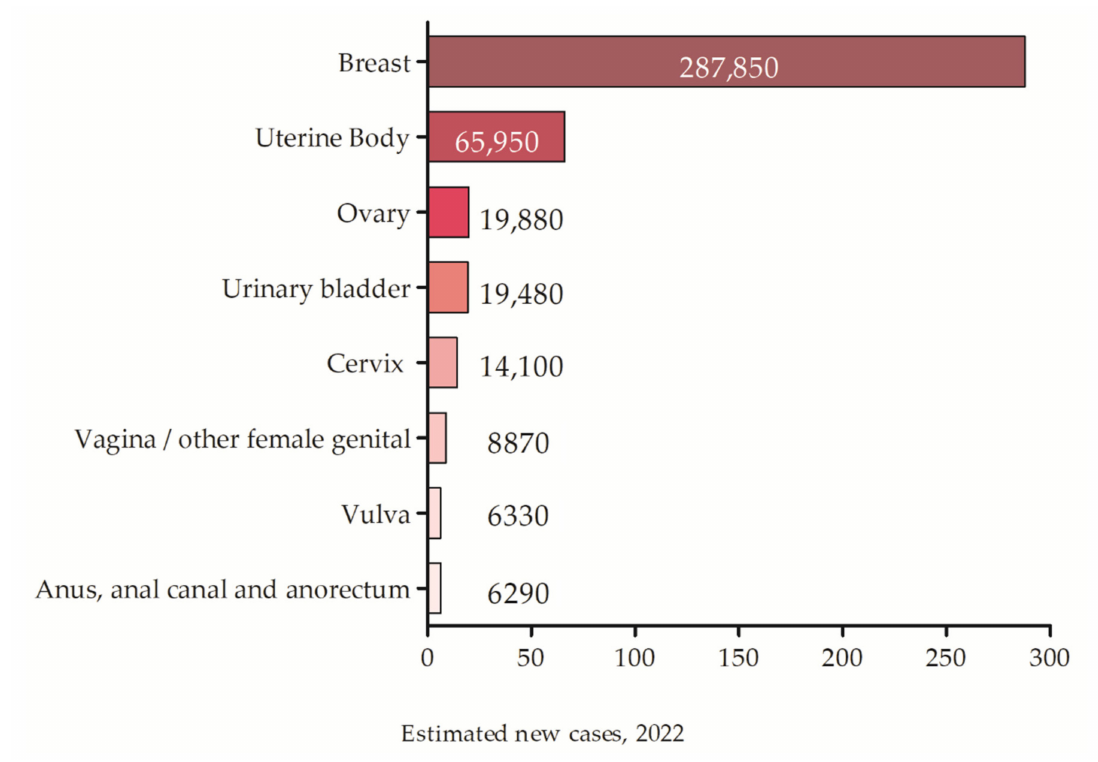
Figure 1. The estimated incidence of gynecological tumors for 2022 according to the